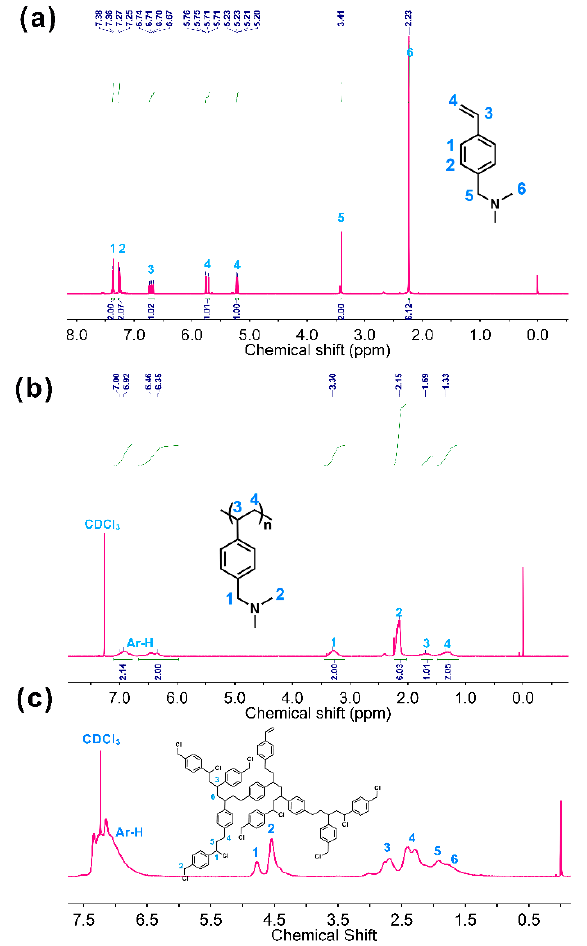
Figure 1. Proton nuclear magnetic resonance ( 1 H NMR) spectra of ( a ) the monomer N , N -Dimethylbenzylamine, ( b ) polyamine poly( N , N -Dimethylbenzylamine), and ( c ) the hyperbranched oligomer HB-PVBC.